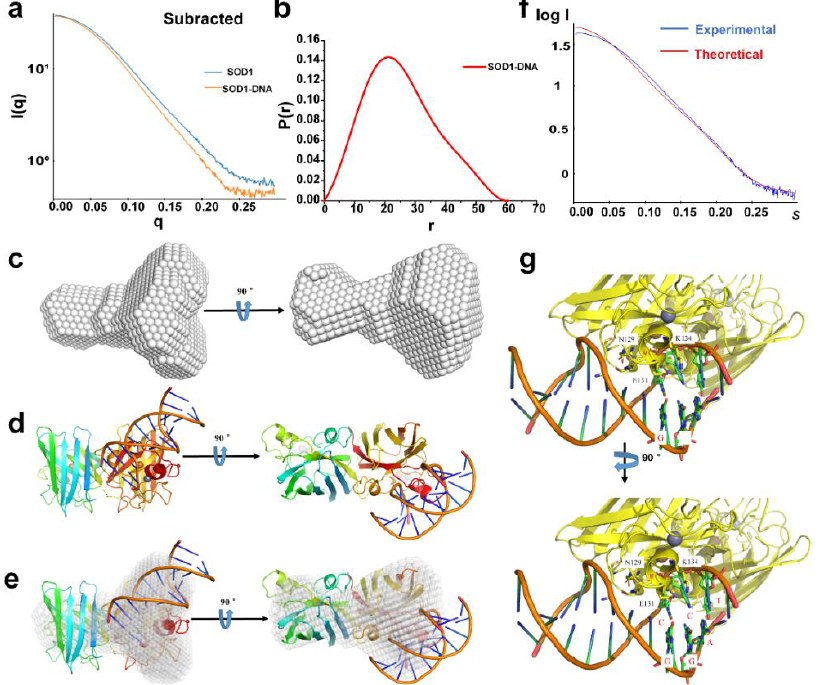
Figure 3. The SAXS analysis of the dsDNA-SOD1 complex. ( a ) Scattering profiles of SOD1 and dsDNA-SOD1 complex under tested conditions. ( b ) P(r) distribution functions of SOD1 and dsDNA-SOD1 complex. ( c ) The profile of the dsDNA-SOD1 complex provided using the SAXS data. ( d ) The optimized structural model of the dsDNA-SOD1 complex provided by HADDOCK based on the conformation stemming from the SAXS data. ( e ) The SAXS profile of the dsDNA-SOD1 complex merged with the HADDOCK model. ( f ) Fitting of the dsDNA-SOD1 complex SAXS data with the HADDOCK model of the dsDNA-SOD1 complex. ( g ) The proposed interaction sites between SOD1 and dsDNA.